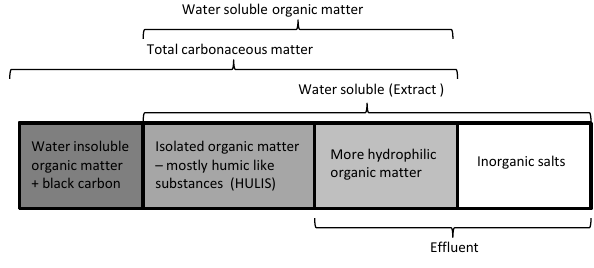
Fig. 1. Classification of a typical aerosol